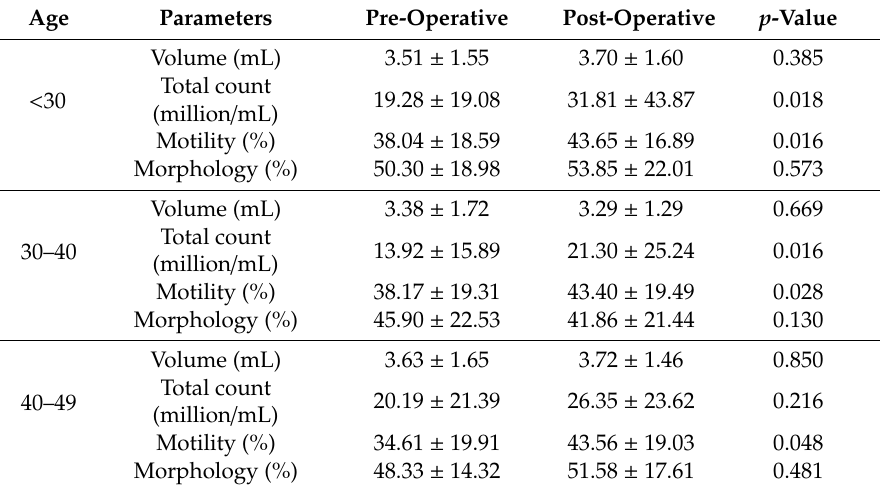
Table 3. Pre- and post- varicocelectomy semen parameters by age groups.